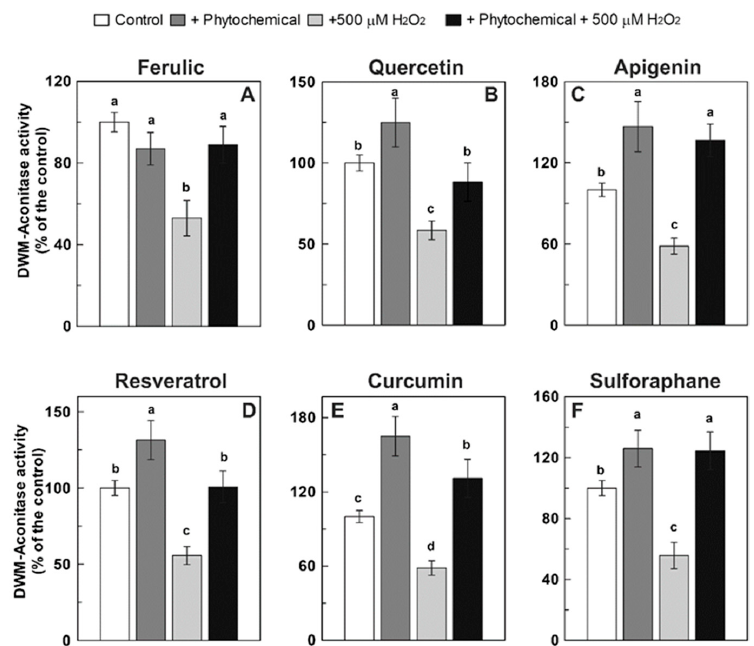
Figure 4 . Effect of different phytochemicals on DWM-aconitase activity, both untreated and treated Figure 4. E ff ect of di ff erent phytochemicals on DWM-aconitase activity, both untreated and treated with 500 µM H 2 O 2 . Measurements were carried out as described in Methods by incubating DWM (150 with 500 µ M